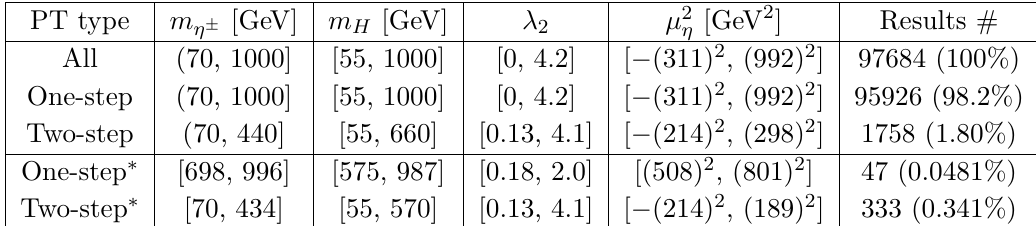
Table 1 . Minimum and maximum values of the independent parameters for each PT obtained from the parameter search ( m A = m ). The last column represents the number of parameter sets η ± calculated considering the relevant constraints. The symbol ∗ in the fourth and fifth rows denotes the PTs which can potentially influence the calculation of dark matter relic abundance.